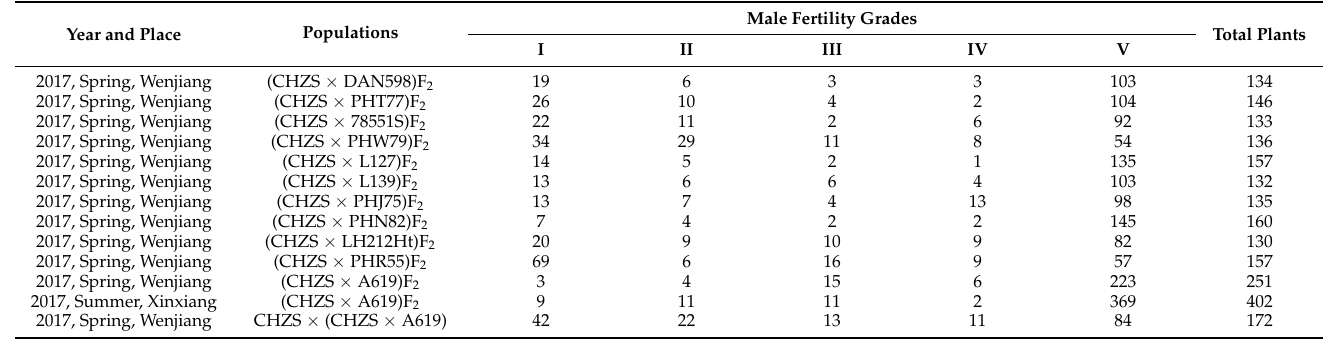
Table 3. Male fertility grade distribution of related F 2 and BC 1 populations.